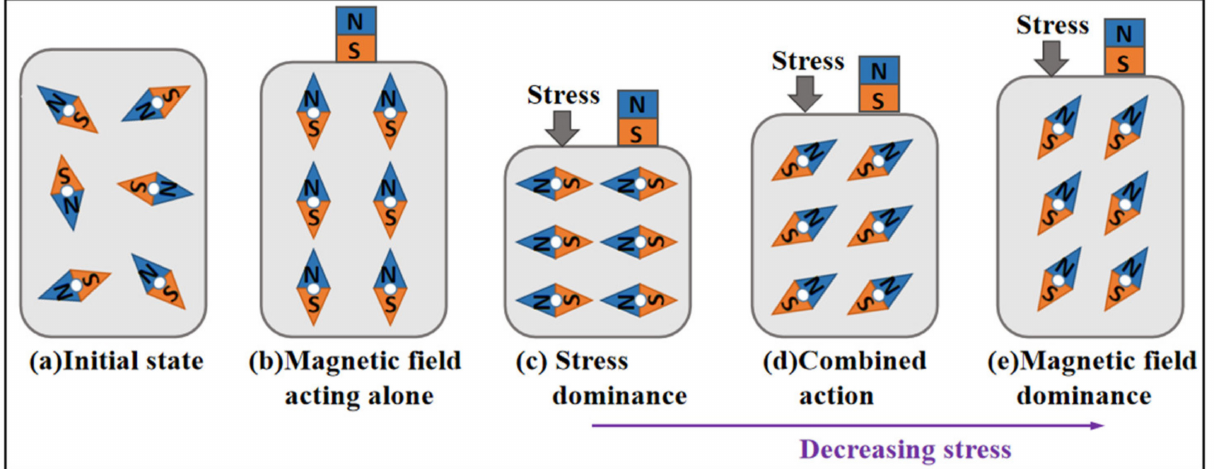
Figure 15. Principle of rotation of magnetic domains in